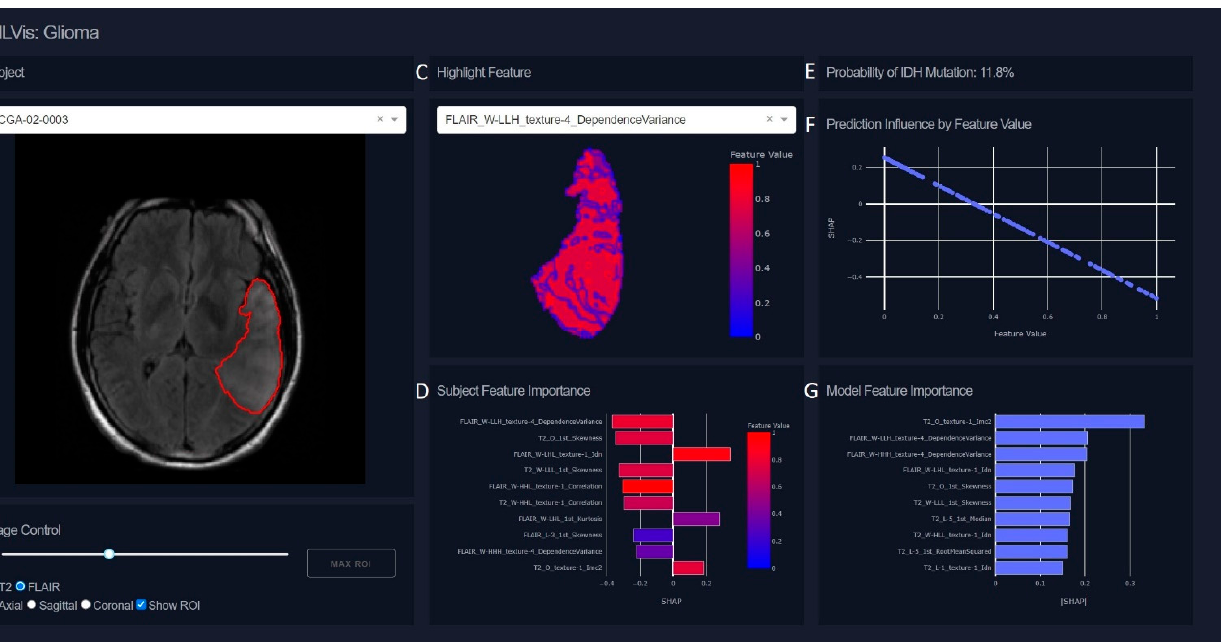
Figure 5. Screenshot of an interactive visualization tool for individual patient model prediction explanations. ( A ) The T2 MRI is shown of the axial slice with the highest cross-sectional area of the ROI (denoted by red boundary). ( B ) Image control options allow navigating through slices via a slide bar, toggling images type between T2 and FLAIR, changing view angle between Axial, Sagittal, and Coronal views, and toggling the ROI display. ( C ) Voxel-wise measurements of this feature are displayed in the space of the ROI. Here, FLAIR_W-LLH_texture-4_DependenceVariance is shown with a gradient color scale where high values are displayed in red, and low values in blue. ( D ) Bar plot of top 10 SHAP values for this patient’s model prediction. Features are ranked by |SHAP| and are colored by the average value of that feature as it relates to the entire cohort; colors on this scale are linked to colors in ( C ). SHAP values can be either positive -corresponding to a higher probability of IDH mutation–or negative–corresponding to a lower probability. The magnitude of the SHAP value denotes the overall importance of that variable to the prediction. ( E ) The predicted probability of IDH mutation for this patient was 11.6%. ( F ) A reference plot for how values of the selected feature (FLAIR_W-LLH_texture-4_DependenceVariance) affect the probability of IDH mutation. High values of FLAIR_W-LLH_texture-4_DependenceVariance are associated with lower SHAP values, indicating the patient is less likely to be IDH mutated with higher levels of FLAIR_W-LLH_texture-4_DependenceVariance. ( G ) Mean |SHAP| for all subjects in the cohort.